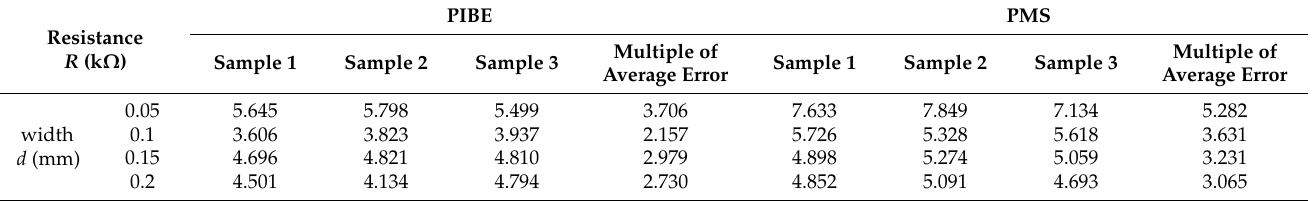
Table 8. Result and error of grid resistance of thin-film resistors of different sizes at 1200 Ω .